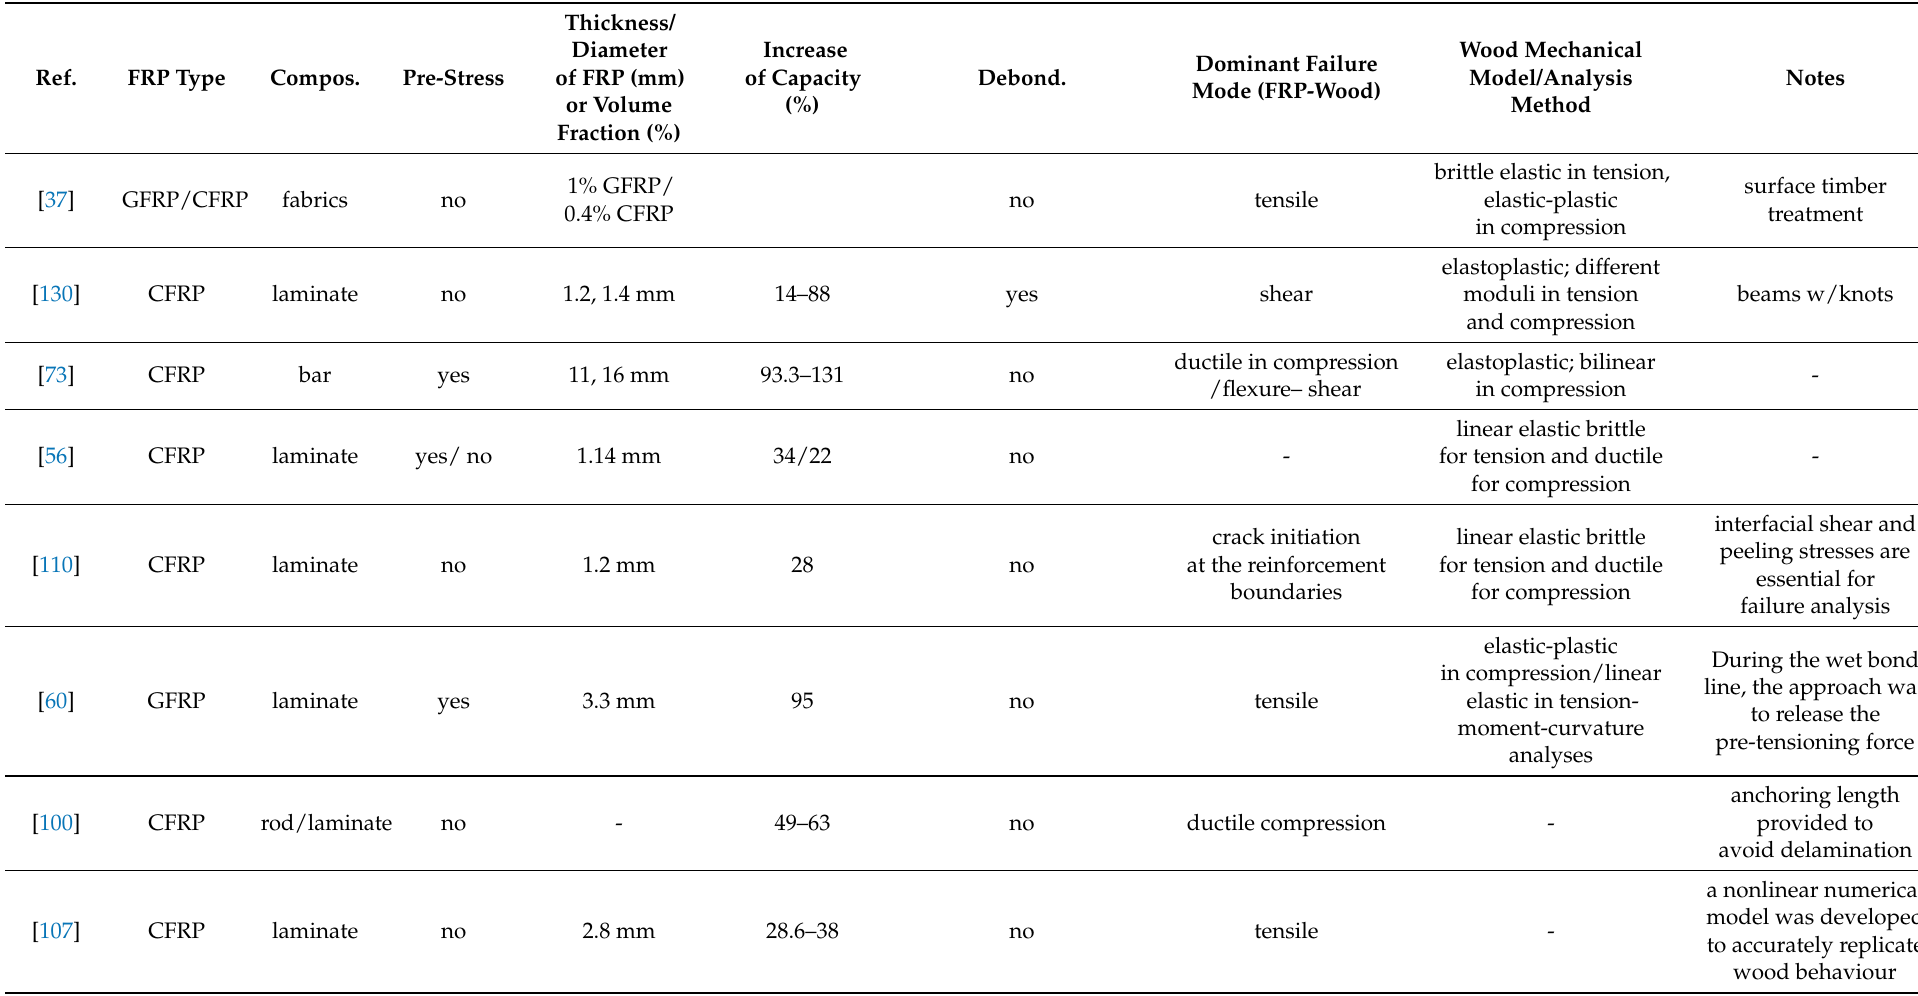
Table 1. Some of the key experimental, FEM, and theoretical studies. Columns in the table indicate the source, FRP type, composite type, applied prestress, size/amount of FRP, increase of capacity, occurrence of debonding, dominant failure mode, model/analysis, and relevant notes, respectively.